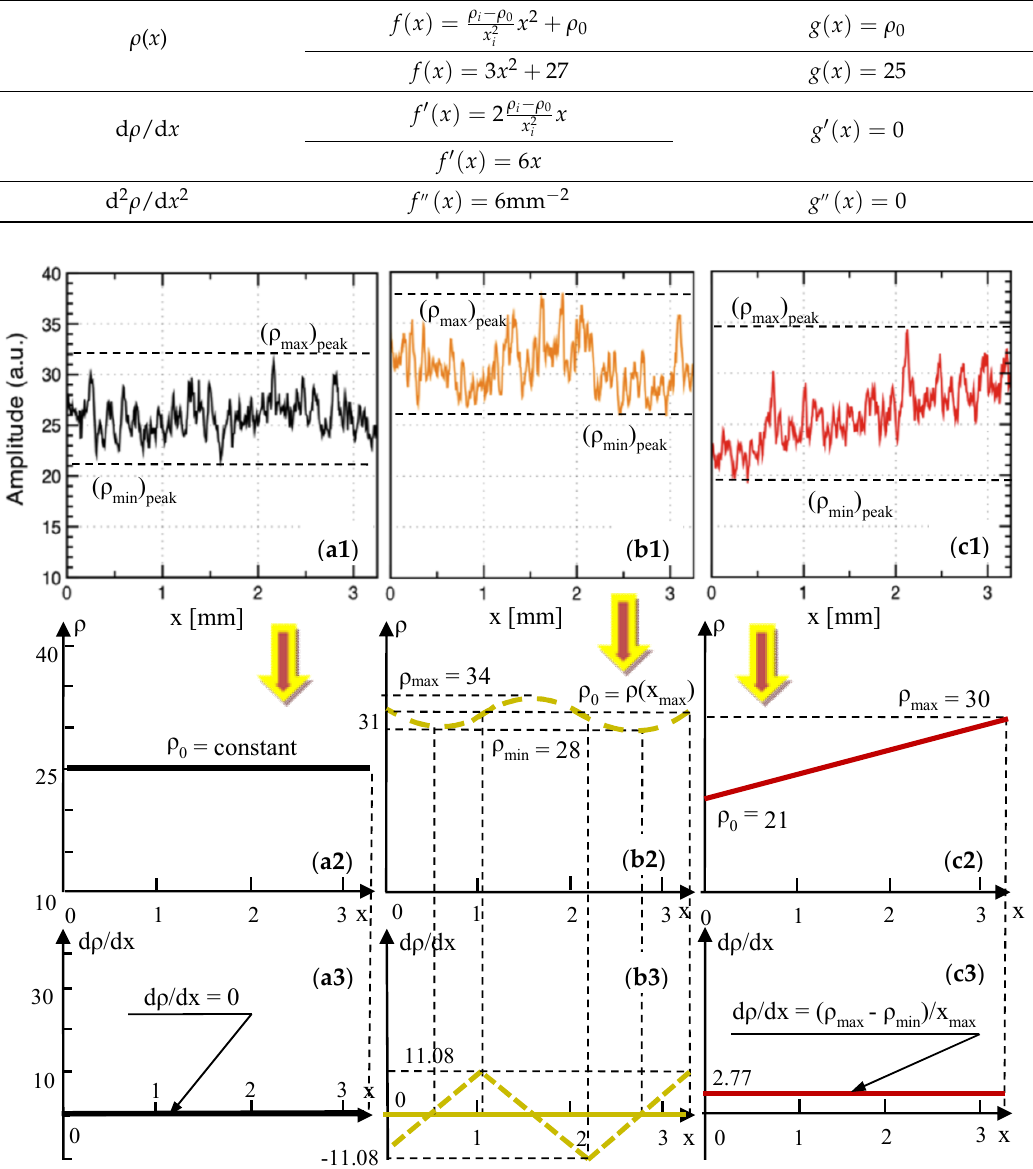
Figure 8. Row ( 1 ): reflectivity profiles, extracted from our previous work [11] (reproduced with permission from MDPI) from en-face OCT images for metal ceramic dental prostheses. Rows ( 2 ) and ( 3 ): reflectivity graphs (i.e., averages of the reflectivity profiles) and gradient of the reflectivity, respectively, obtained from Appendix B3 and in the text, as well as shown in Table 6, for Group H30. ( a1–a3 ), Group N: for the sample pressed at the normal temperature of 930 °C, prescribed by the manufacturer. ( b1–b3 ), Group H30: for the sample pressed at 960 °C (30 °C above the normal temperature). ( c1–c3 ), Group H50: for the sample pressed at 980 °C (50 °C above the normal temperature).